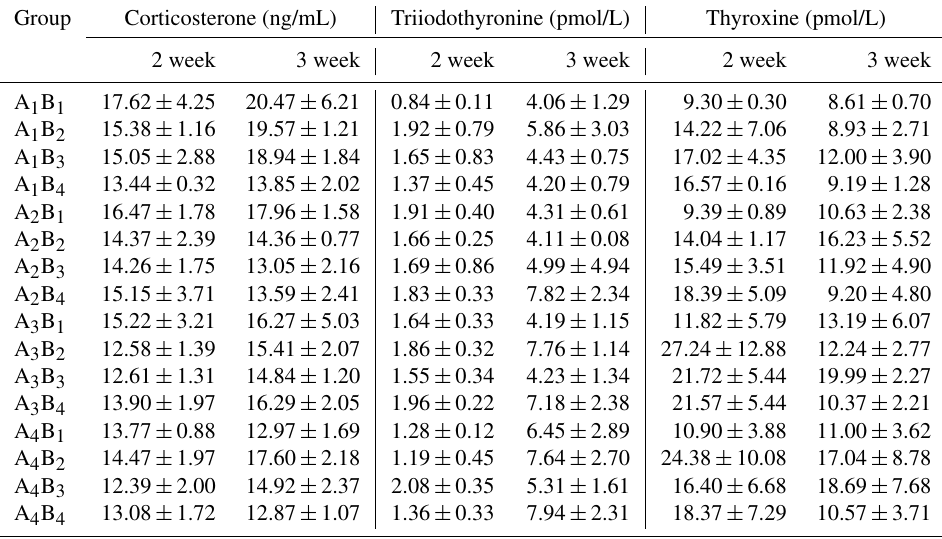
Table 5. The plasma corticosterone and thyroid hormone of Arbor Acres broilers under low temperature conditions supplemented by glu- tamine and